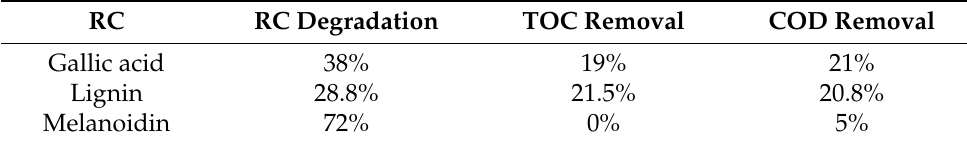
Table 2. Degradation of the studied RC obtained at the end of the applied OL experiments.